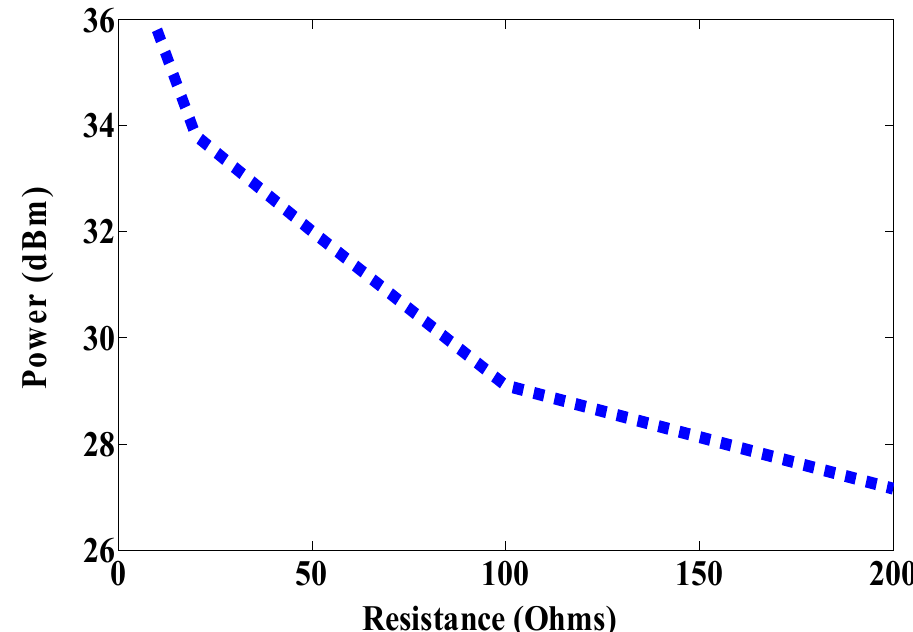
Figure 16. Measured minimum power to activate sensor node at 937 MHz (antenna C).